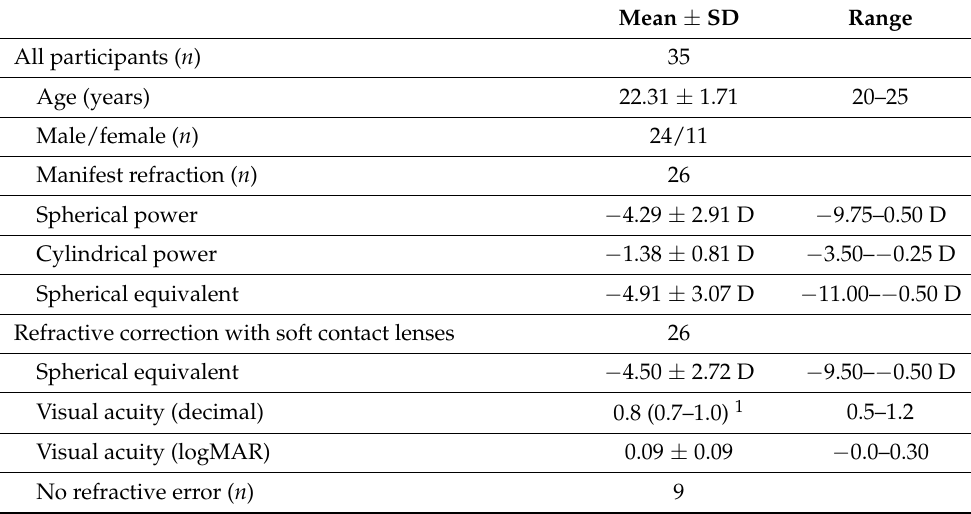
Table 1. Demographic and refractive characteristics of the study